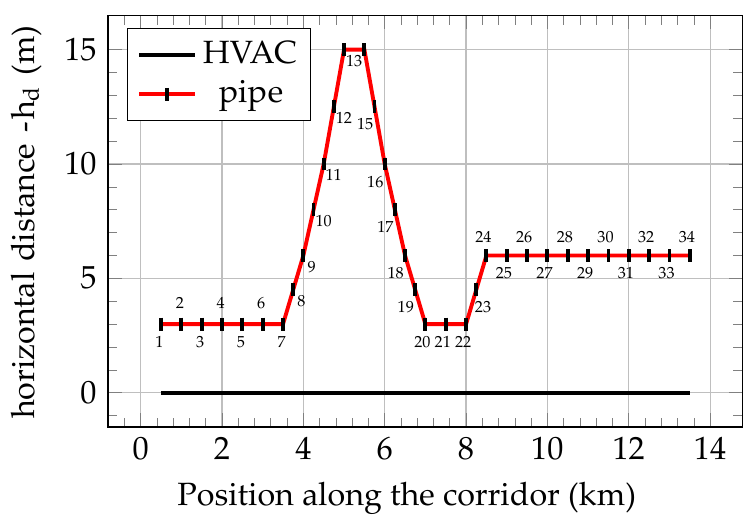
Figure 1. Pipeline horizontal position with respect to the HVAC power line along the length of the corridor